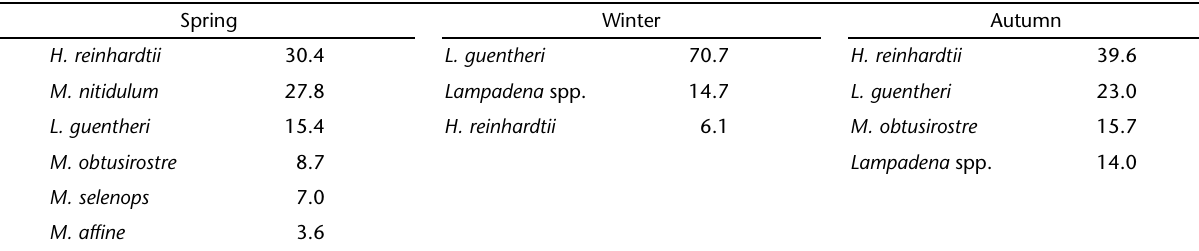
Table IV. Contribution percentage (90%) of the most abundant taxa during the spring, winter and autumn for the average similarity, as determined by SIMPER. Taxa were listed according to its contribution for average similarity within each group. Spring